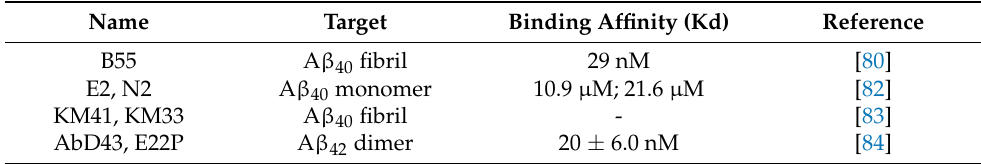
Table 3. RNA aptamers with respective target and binding affinity.